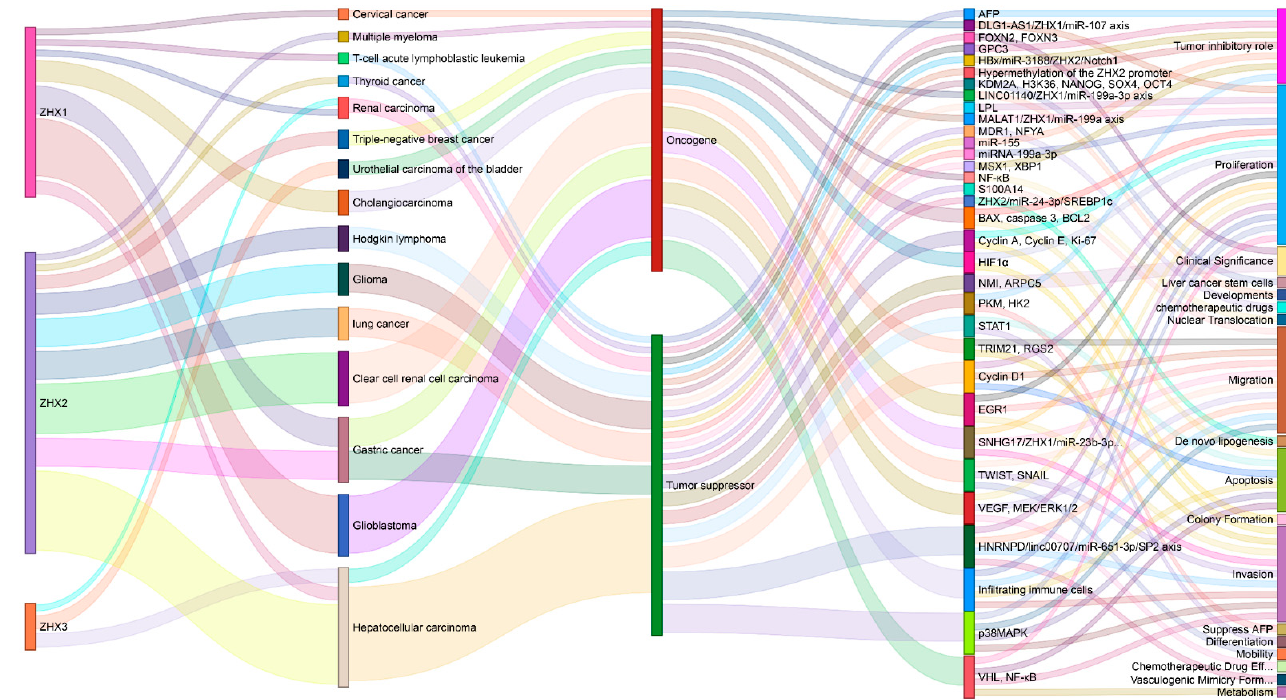
Figure 5. A comprehensive illustration of ZHXs as a double-edged sword in cancers: an oncogene or tumor suppressor, underlying mechanisms, and biological functions.